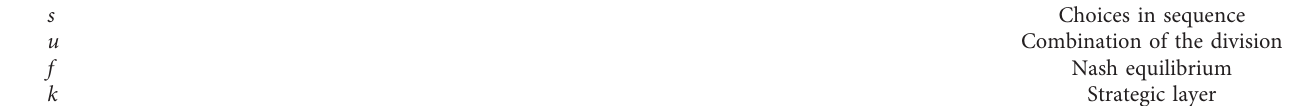
Table 1: Variables used in equation (6).